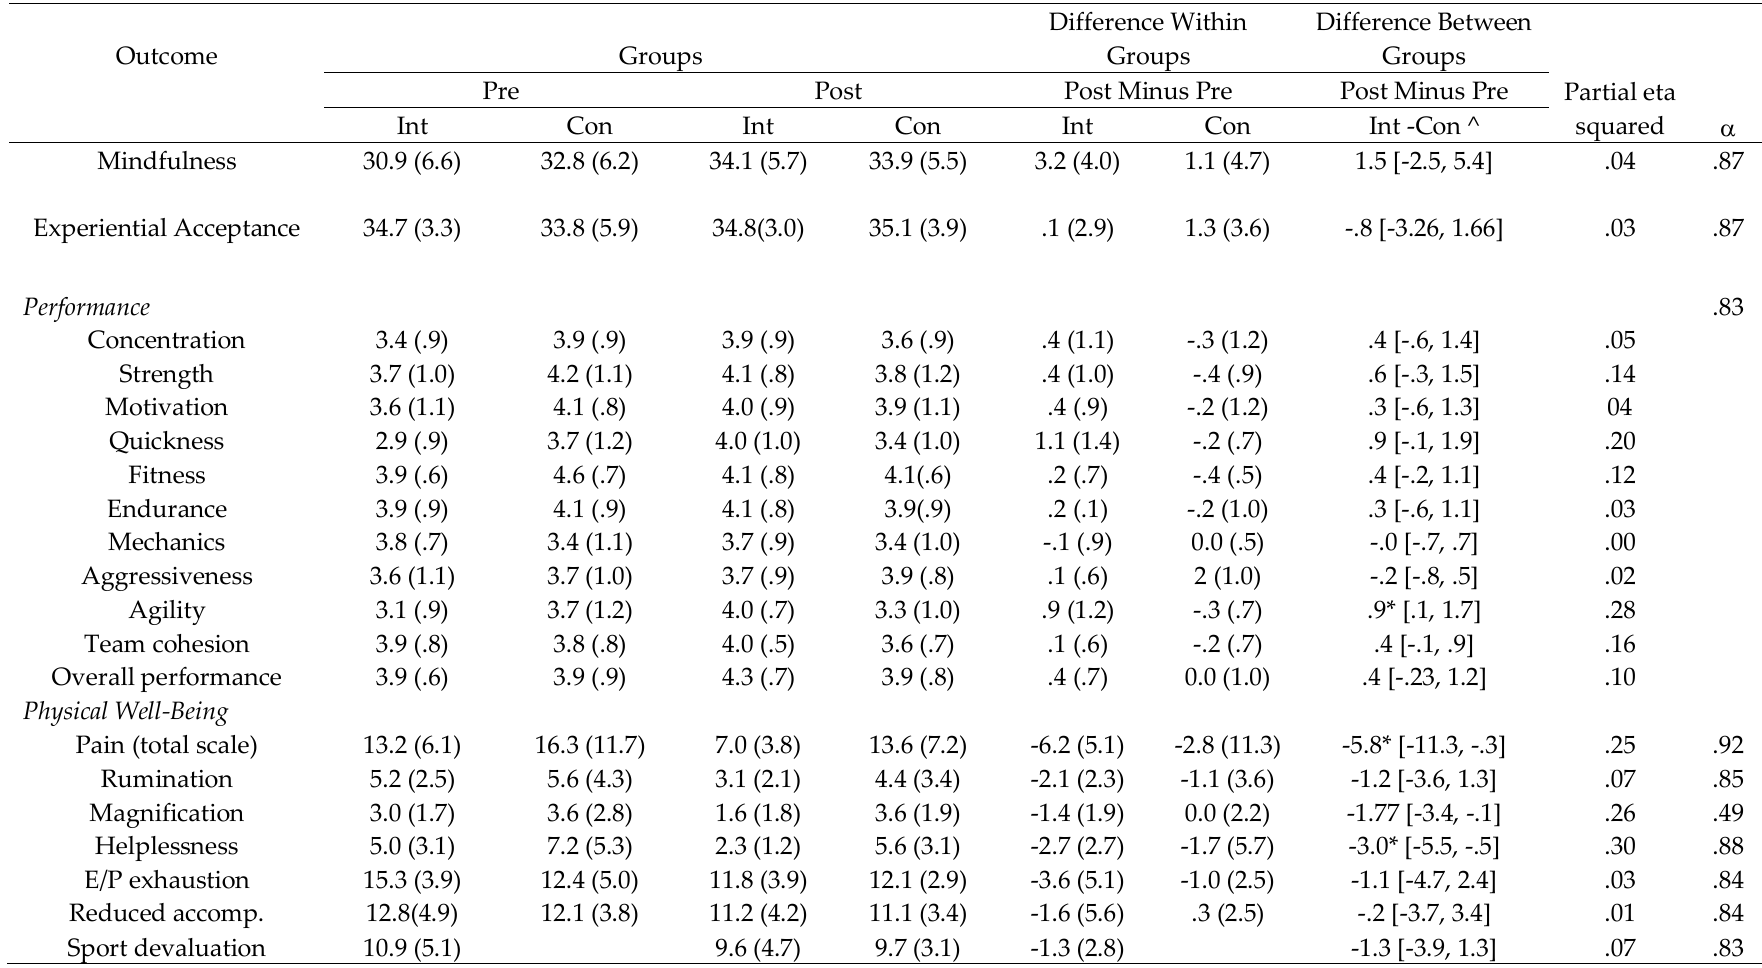
Table 4: Mean ( SD ) of Groups, Mean ( SD ) Difference Within and Between Groups (95% CI), and Alpha Coefficients for Outcomes of Hypothesis Two and Three Outcome Groups